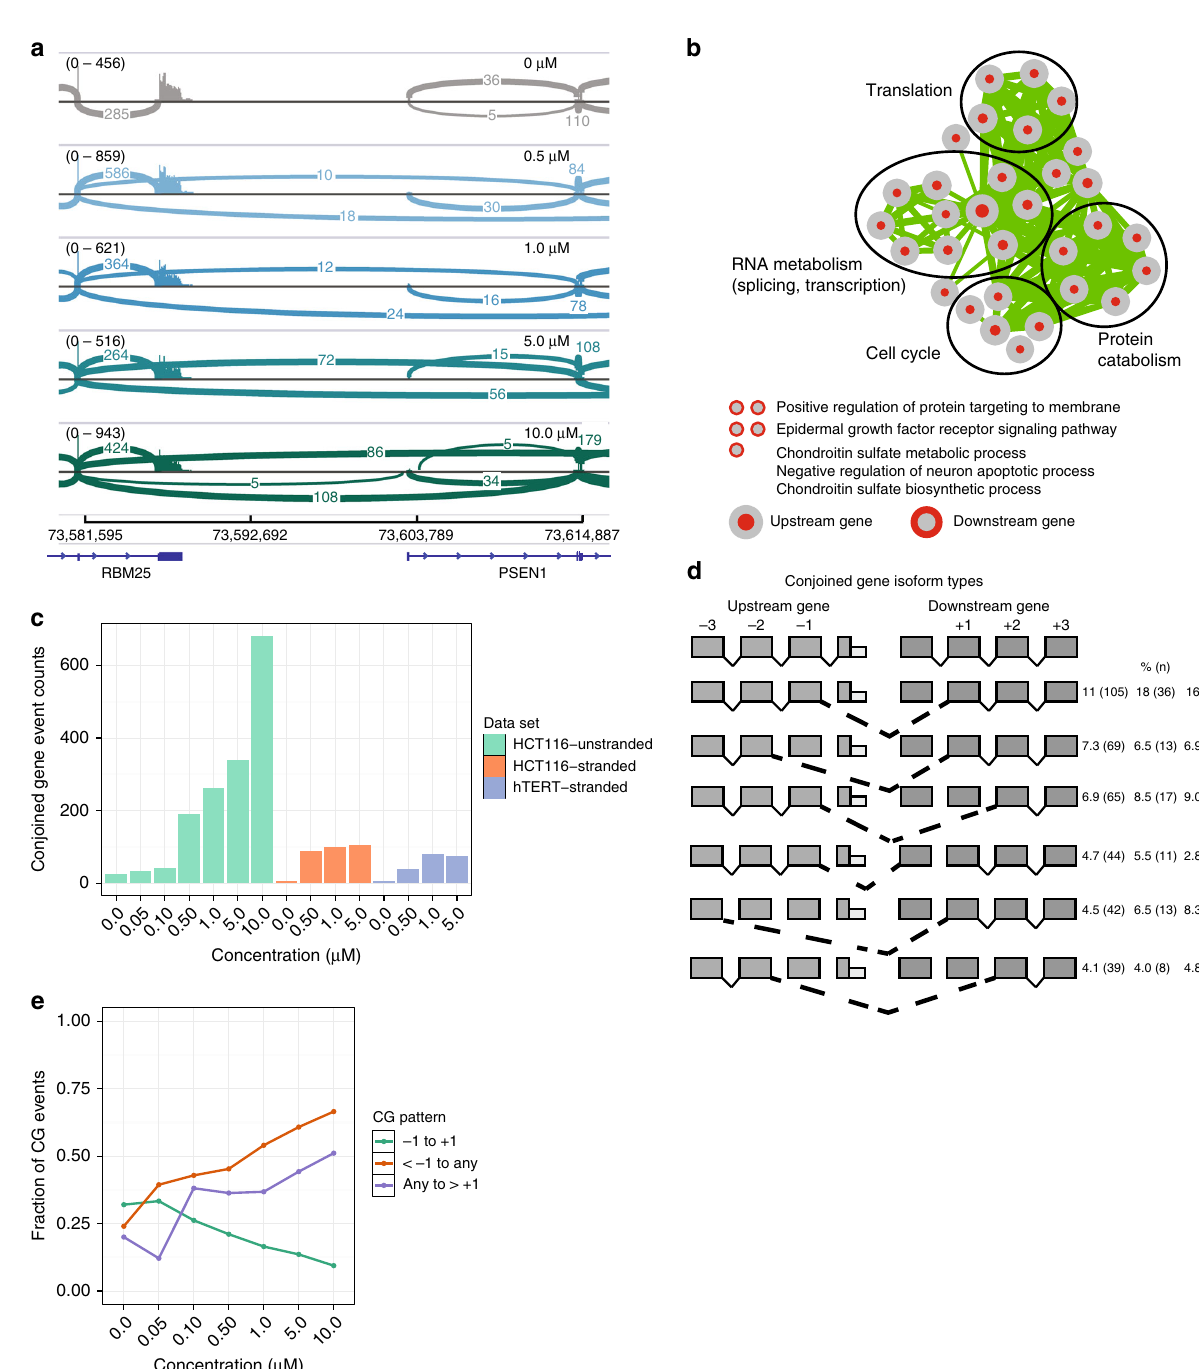
Fig. 3 Characteristics of CG transcripts induced by inhibition of CLK. a IGV-generated sashimi plot 62 of the RBM25-PSEN1 CG. Plots for T3 treatment concentrations of 0.0, 0.5, 1.0, 5.0, and 10.0 µ M are shown from top to bottom . The control sample plot is colored gray , and the treated sample plots are colored according to T3 concentration. RefSeq gene annotations are shown in blue at the bottom of the plot along with chromosome 12 coordinates (bp). For each sample, the y -axis represents read coverage normalized by (1,000,000/total reads), and the value range is indicated between brackets . Arcs connecting exons represent reads spliced across introns, with the number of spliced reads annotated over the line. Only arcs representing at least fi ve reads are shown. b Enrichment map for genes involved in CGs in the HCT116 unstranded RNA-Seq data set. Each node represents a GO BP gene set. BP enriched in CG upstream partners have red cores , while BP enriched in downstream partners have red outer rings . Edge thickness indicates the level of CG partner overlap between gene sets. c CG counts per RNA-Seq library as detected by a modi fi ed deFuse classi fi er. d Top CG splicing patterns for the HCT116 unstranded RNA-Seq data set. Schematic shows the most abundant conjoined splicing relationships between in-cis gene pairs. Right of fi gure, percentage of all CG events (number of events in class) for HCT116 unstranded, HCT116 stranded, and 184hTERT stranded libraries, respectively. e Dose-dependent CG splicing pattern proportions across T3 concentrations for the HCT116 unstranded RNA-Seq data set. As T3 concentration is increased, more exons are skipped. See panel d for splicing